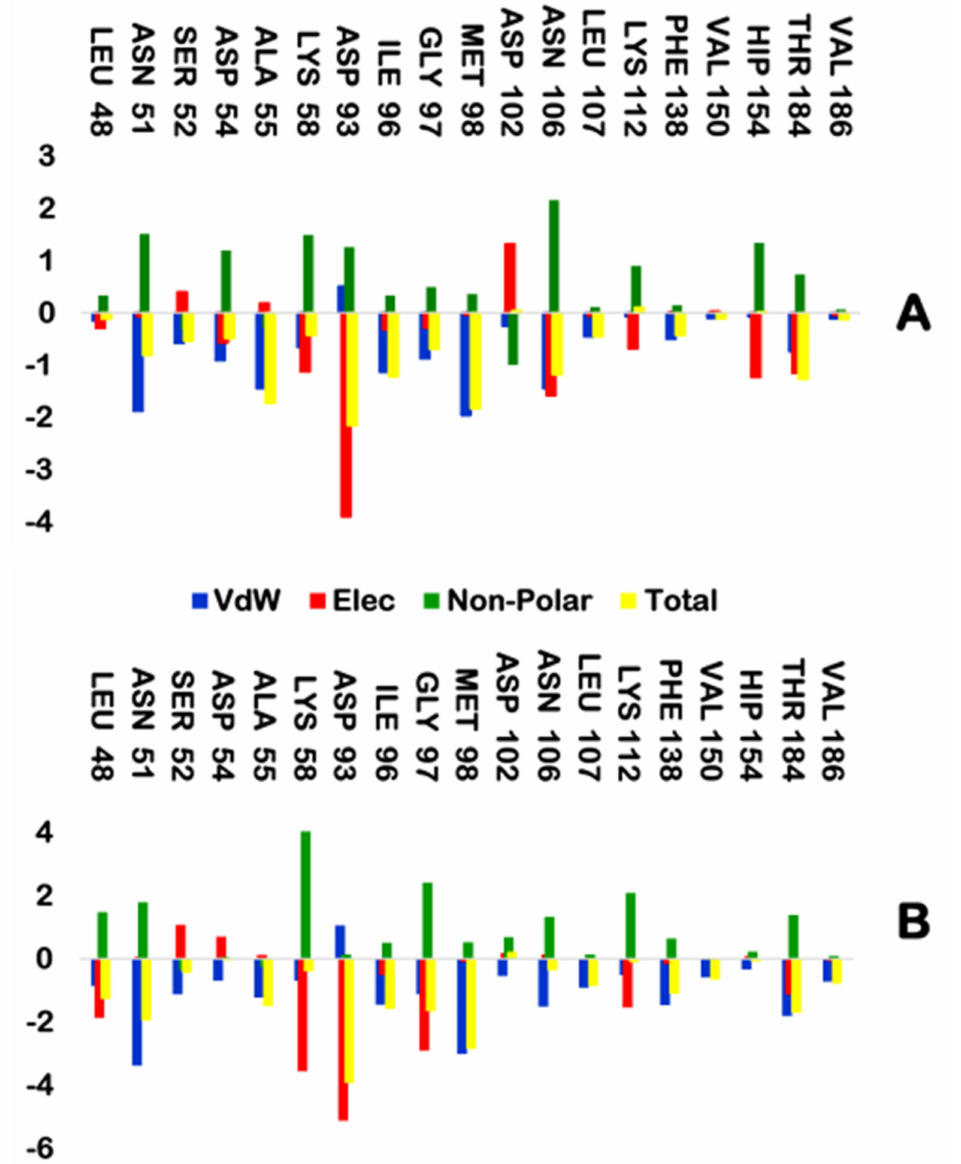
Figure 10. The per-residue free energy decomposition of ( A ) NT-RD and ( B )